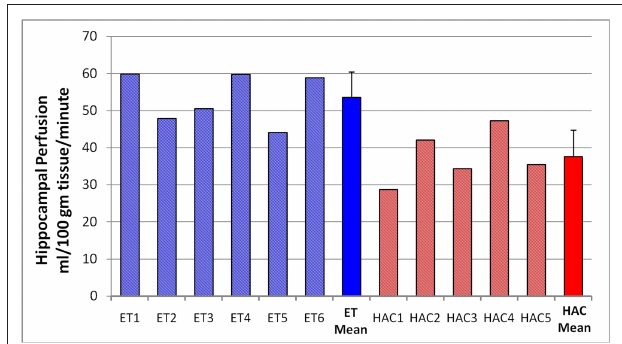
Table 2 | Summary global network metrics for both groups. Note that there were no statistically significant differences between the two groups for degree or for global and local efficiency ( E are the metrics calculated on equivalent random